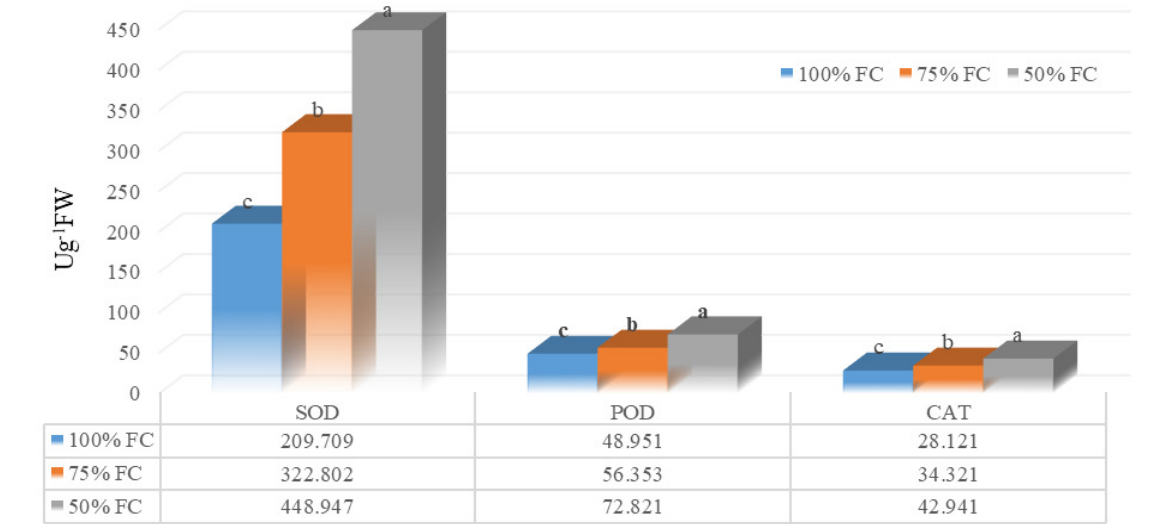
Fig. 3. Changes in the enzymatic activities (Superoxide dismutase (SOD), peroxidase (POD) and catalase (CAT)) for thirty-four genotypes under stress and non-stress conditions in Ug -1 FW (Units g -1 fresh weight). Different letters indicate significant differences. FC stands for field